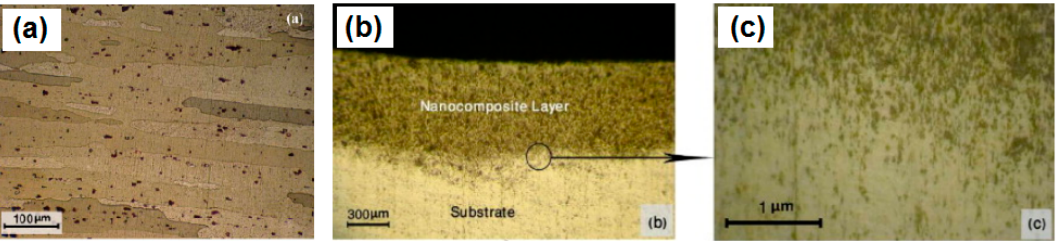
Figure 8. Microstructure of Al2024 (reproduced from [65], with permission from Elsevier, 2010): ( a ) microstructure of the base Al2024; ( b ) cross-sectional microstructure with Al 2 O 3 particles after single-pass FSP; ( c ) interfacial microstructure with Al 2 O 3 particles.